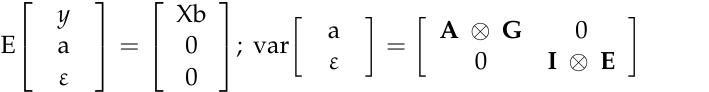
= additive genetic; σ 2 = residual), heritability estimates (h 2 ) and R A